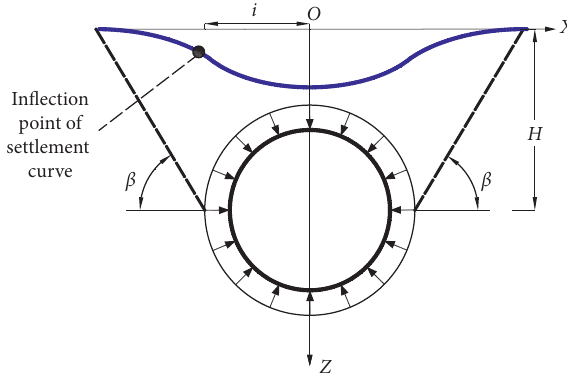
Figure 4: Influence zone of ground settlement and influence angle β . Table 1: Calculation parameters of case studies [6, 29, 35–37].